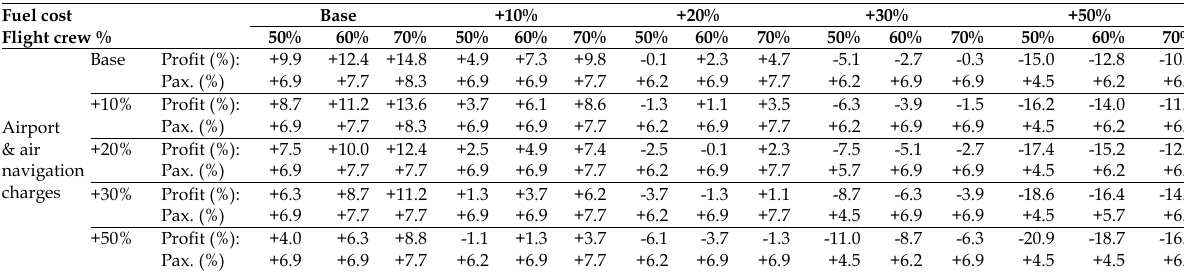
Table 13. Sensitivity analysis for the cost figures of Clip-Air Fuel